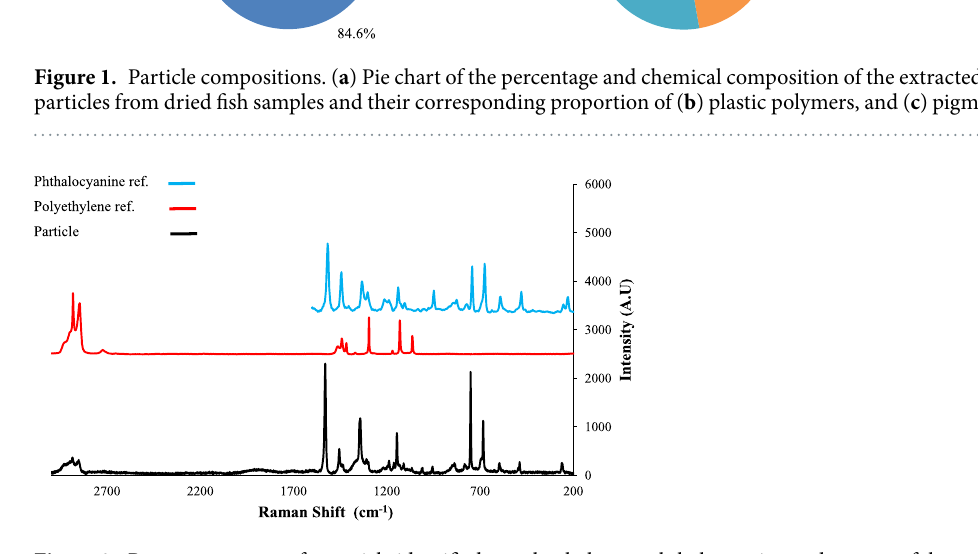
Figure 2. Raman spectrum of a particle identified as polyethylene + phthalocyanine and spectra of the reference